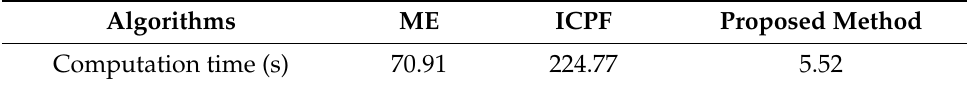
Table 11. Computation time comparison of individual